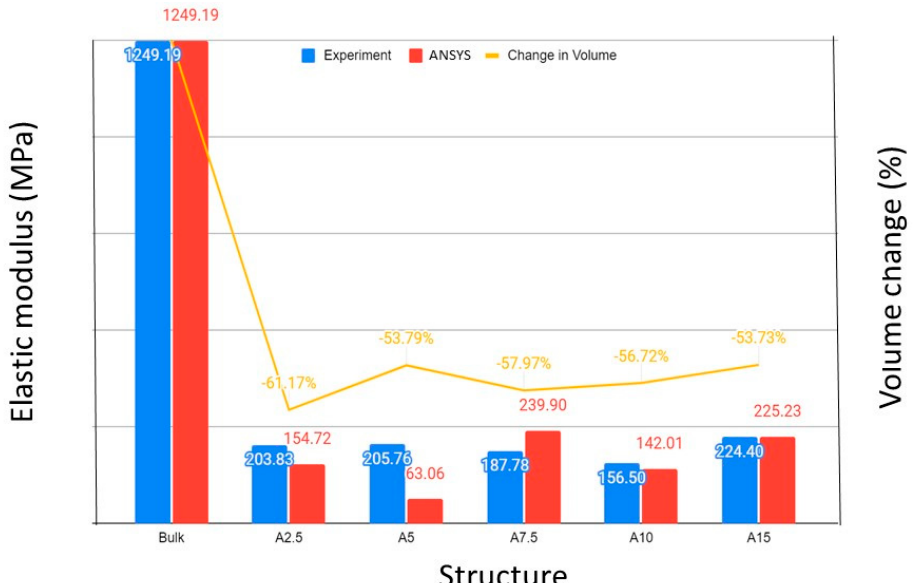
Figure 4. Experimental and FEM results of the elastic modulus of various bamboo-like structures. The elastic modulus of a solid (bulk) structure with the same dimensions and the volume change for each structure relative to the bulk structure are also included to illustrate the enhanced compliance and significantly lower weight of the bamboo-like structures.